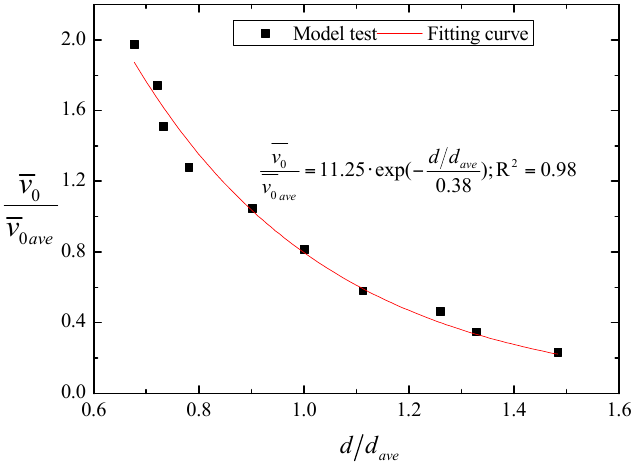
Figure 3. The dimensionless relationship between the droplet diameter and velocity of the physical model test.